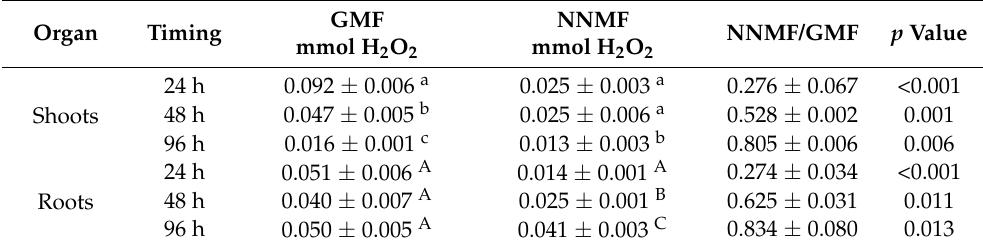
Table 7. Time-course analysis of H 2 O 2 production in Arabidopsis thaliana under GMF and NNMF. Values are expressed as mmol H 2 O 2 and fold change (NNMF/GMF). Within the same column, the letters indicate statistical difference ( p < 0.05) among shoots (lowercase letters) or roots